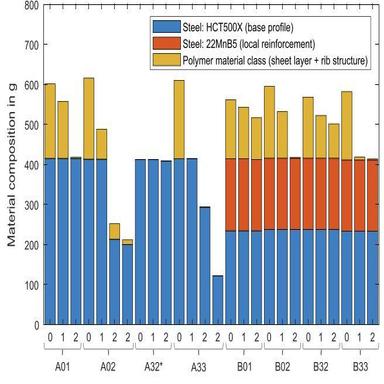
Material compositions of steel-containing particles, referenced by their initial sample identifiers, (0) in initial state before shredding, (1) after first shredding and (2) after second shredding. Initial mass of input samples varied slightly. Steel components were fully liberated from attached polymers in a few cases and broke into two progeny particles in two cases (A02, A33 in second sequence). \Note: Sample A32 was not further investigated due to liberation prior to experiments.